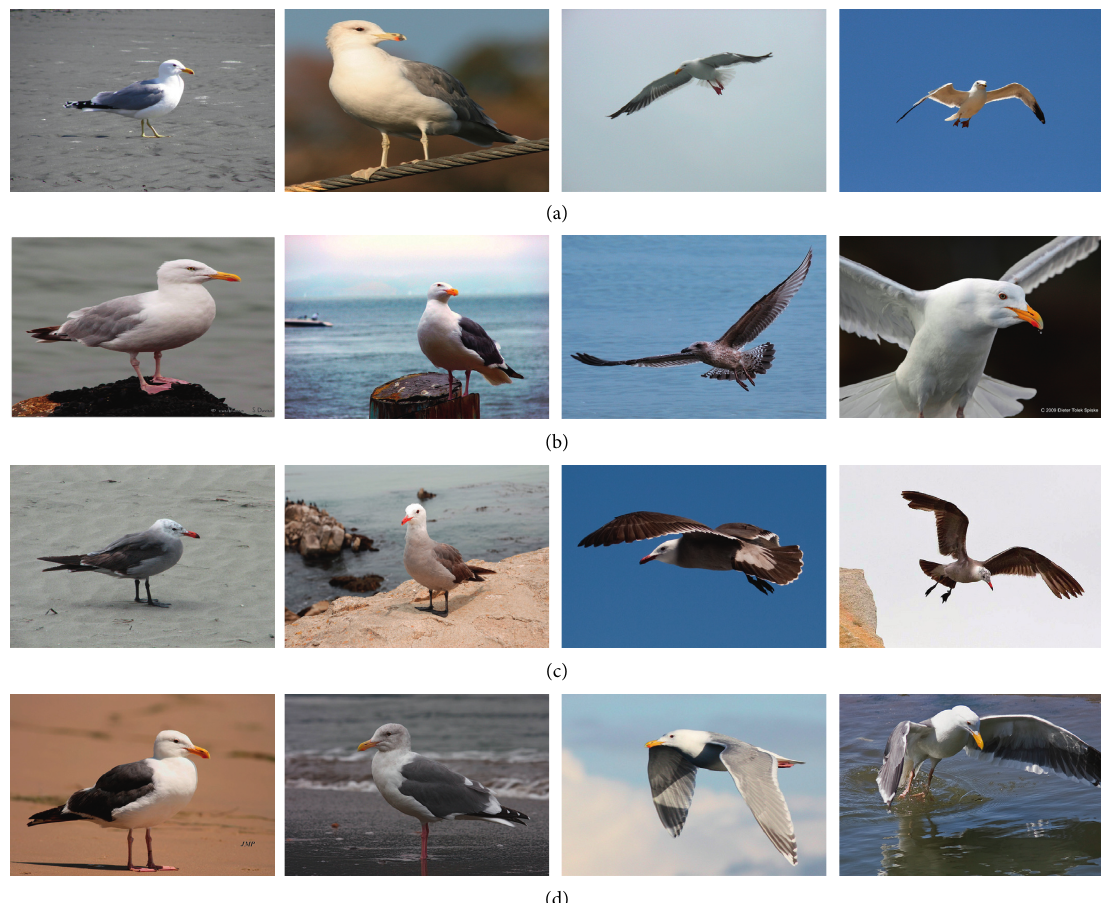
Figure 1: Samples from the Caltech-UCSD Birds-200-2011 dataset. The subcategories of birds in the four subfigures in a row are all the same, and the birds in all the subfigures belong to the same category: (a) California Gull; (b) Herring Gull; (c) Heermann’s Gull; (d) Western